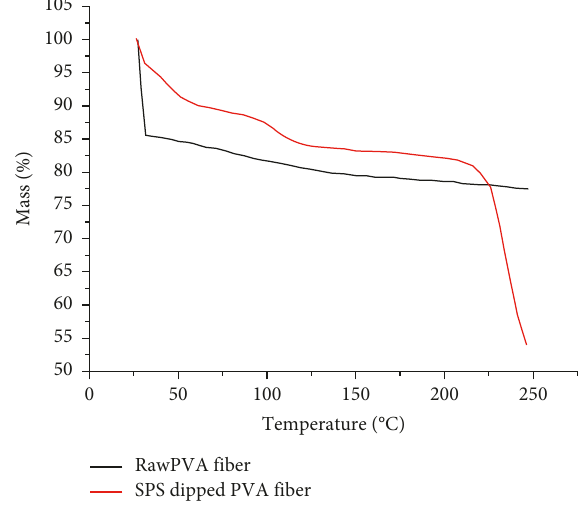
Figure 4: TGA of raw and SPS-dipped PVA fiber.